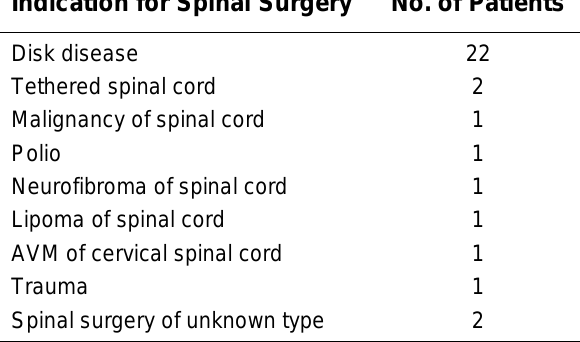
Indications for Spinal Surgery Indication for Spinal Surgery